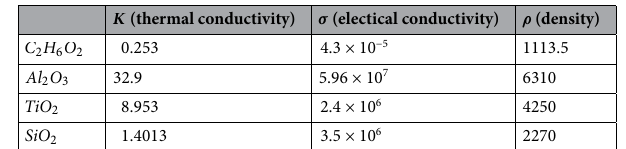
K (thermal conductivity) σ (electical conductivity) ρ (density)